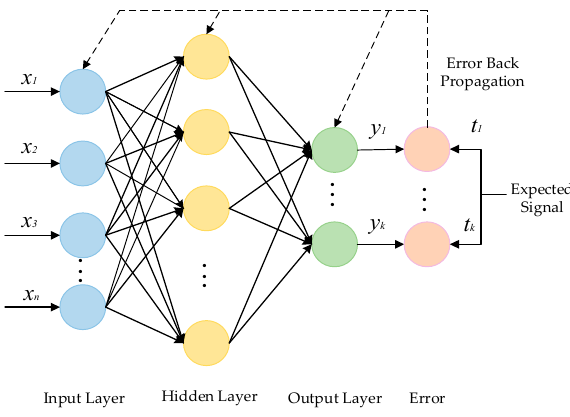
Figure 5. Schematic diagram of BPNN structure. The BPNN hidden layer function is one that runs on the neurons of the artificial neural network and is responsible for mapping the input of the hidden layer to the output. The hidden layer function introduces nonlinear factors into the neural network, so that BPNN can approximate any nonlinear function and apply it to more nonlinear models. The BPNN output layer commonly used linear functions; the commonly used functions of the hidden layer are the logsig function and the tansig function, the expressions of which are shown in Equations (1) and (2), respectively [22].